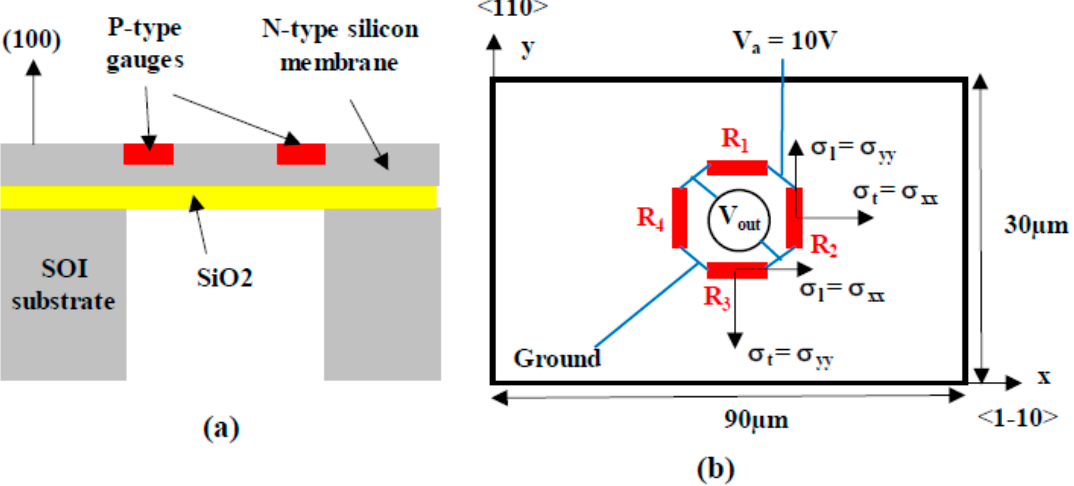
Figure 2. ( a ) Cross sectional view of the sensor; ( b ) Wheatstone bridge on the rectangular